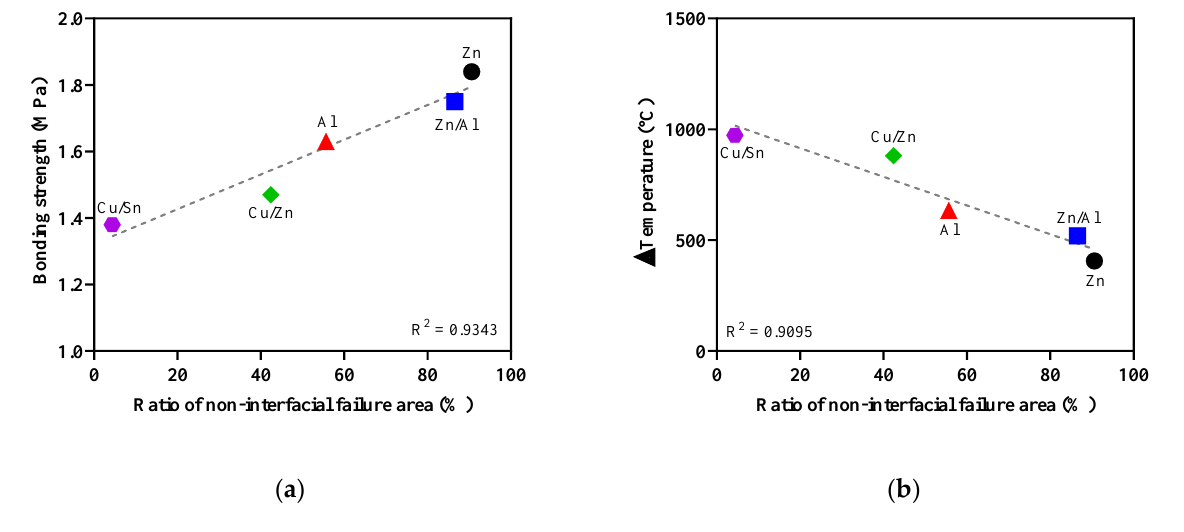
Figure 14. Relationship RN and ( a ) bonding strength and ( b ) Δtemperature.